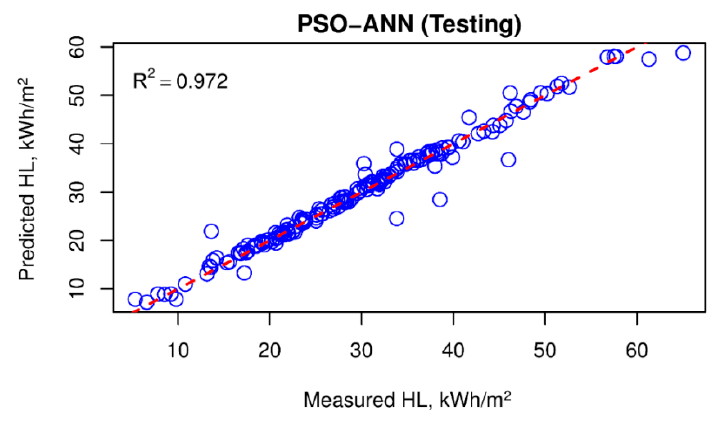
Figure 13. HL predictions on the testing dataset of the PSO-ANN model.